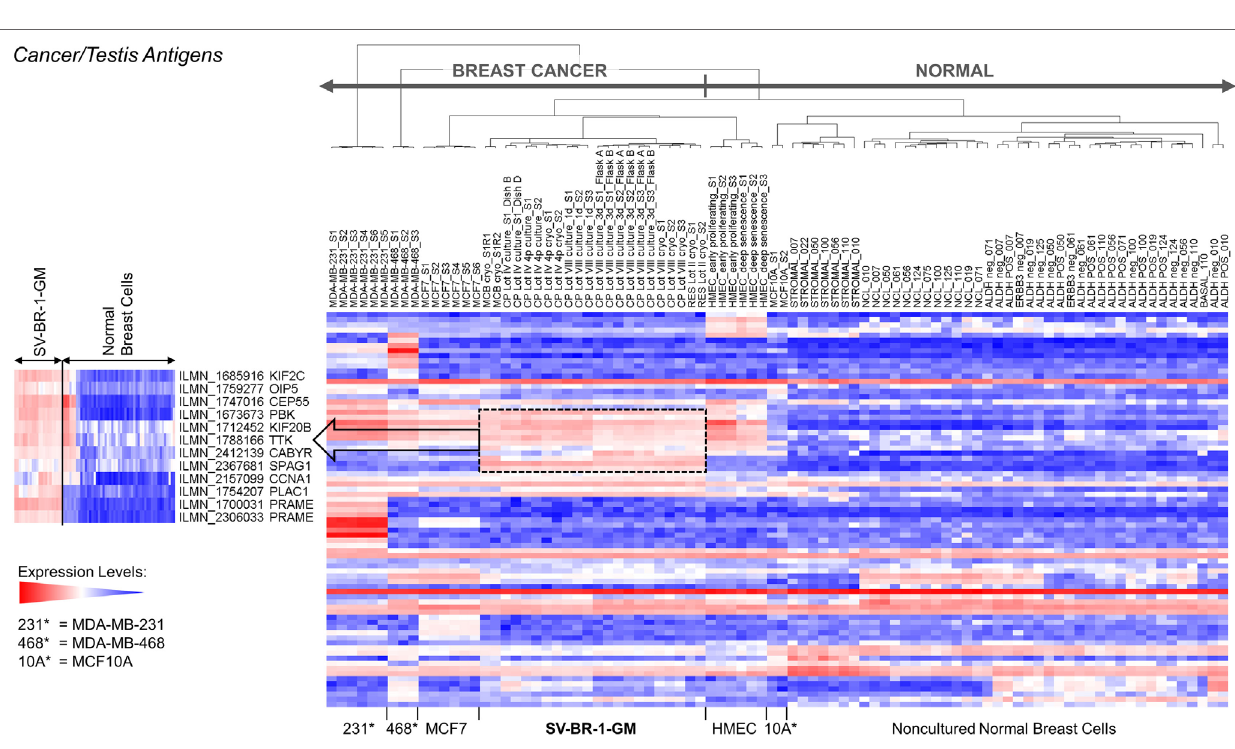
FigUre 7 | Cancer/testis antigen (CTA) expression in SV-BR-1-GM cells. RNA expression levels of 279 confirmed or putative CTAs (Data Sheets S4 in Supplementary Material) were compared between SV-BR-1-GM, other established breast cancer cell lines, and several normal human breast cell types. Quantile- normalized and log2-transformed microarray-based RNA expression levels are displayed according to a global gradient color scheme. Red means a higher expression level than white, and white means a higher expression level than blue. Only CTAs with a maximum representative expression value among all samples > 1.5 times the background cutoff value were